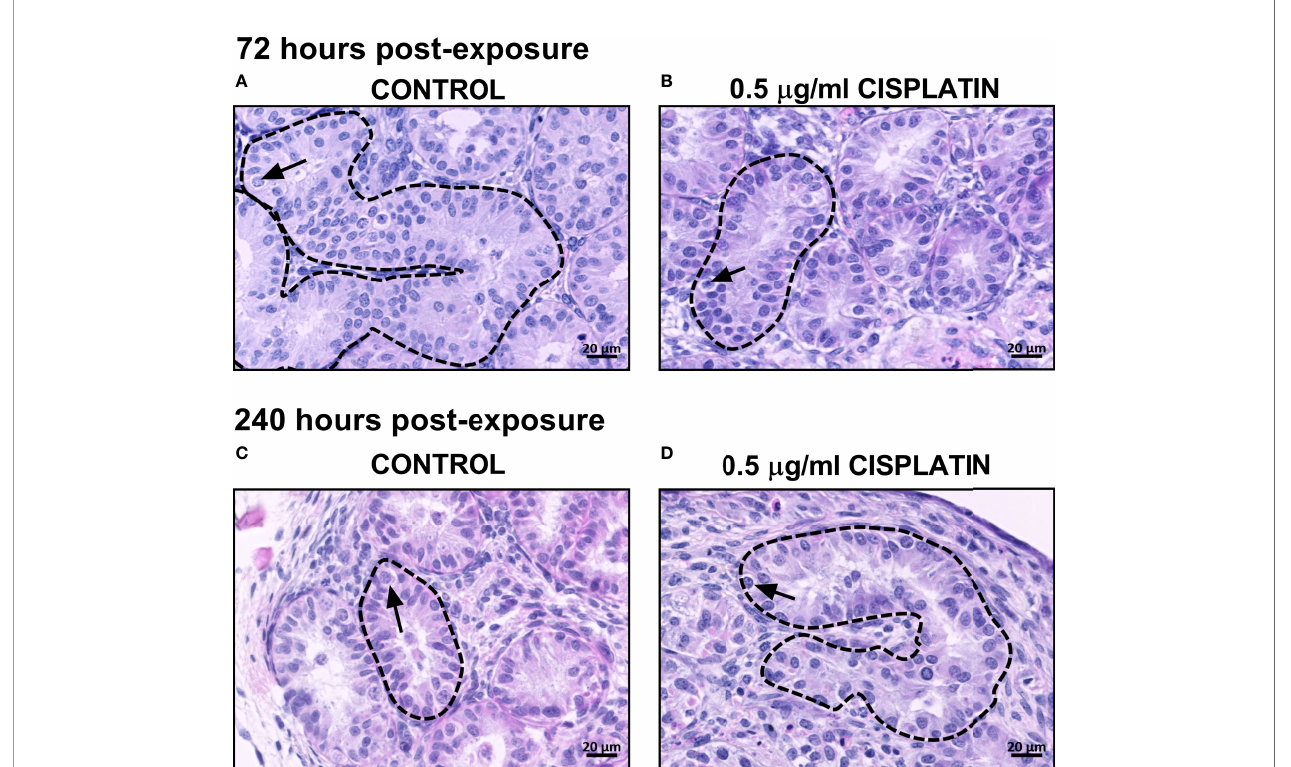
FIGURE 1 | Effects of exposure to cisplatin on the gross morphology of human fetal testicular tissues at 72 and 240 hours post-exposure. H&E staining in vehicle control (A, C) and cisplatin-exposed (B, D) tissues at 72 and 240 hours post-exposure. Dotted lines outline seminiferous cords and arrows point to germ cells. Scale bars represent 20 m